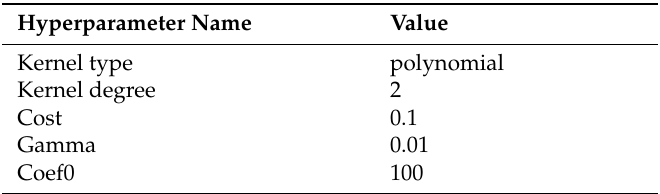
Table 2. Settings of the Support Vector Machine (SVM)’s hyperparameters achieving highest 10-fold-cross validation accuracy on the training